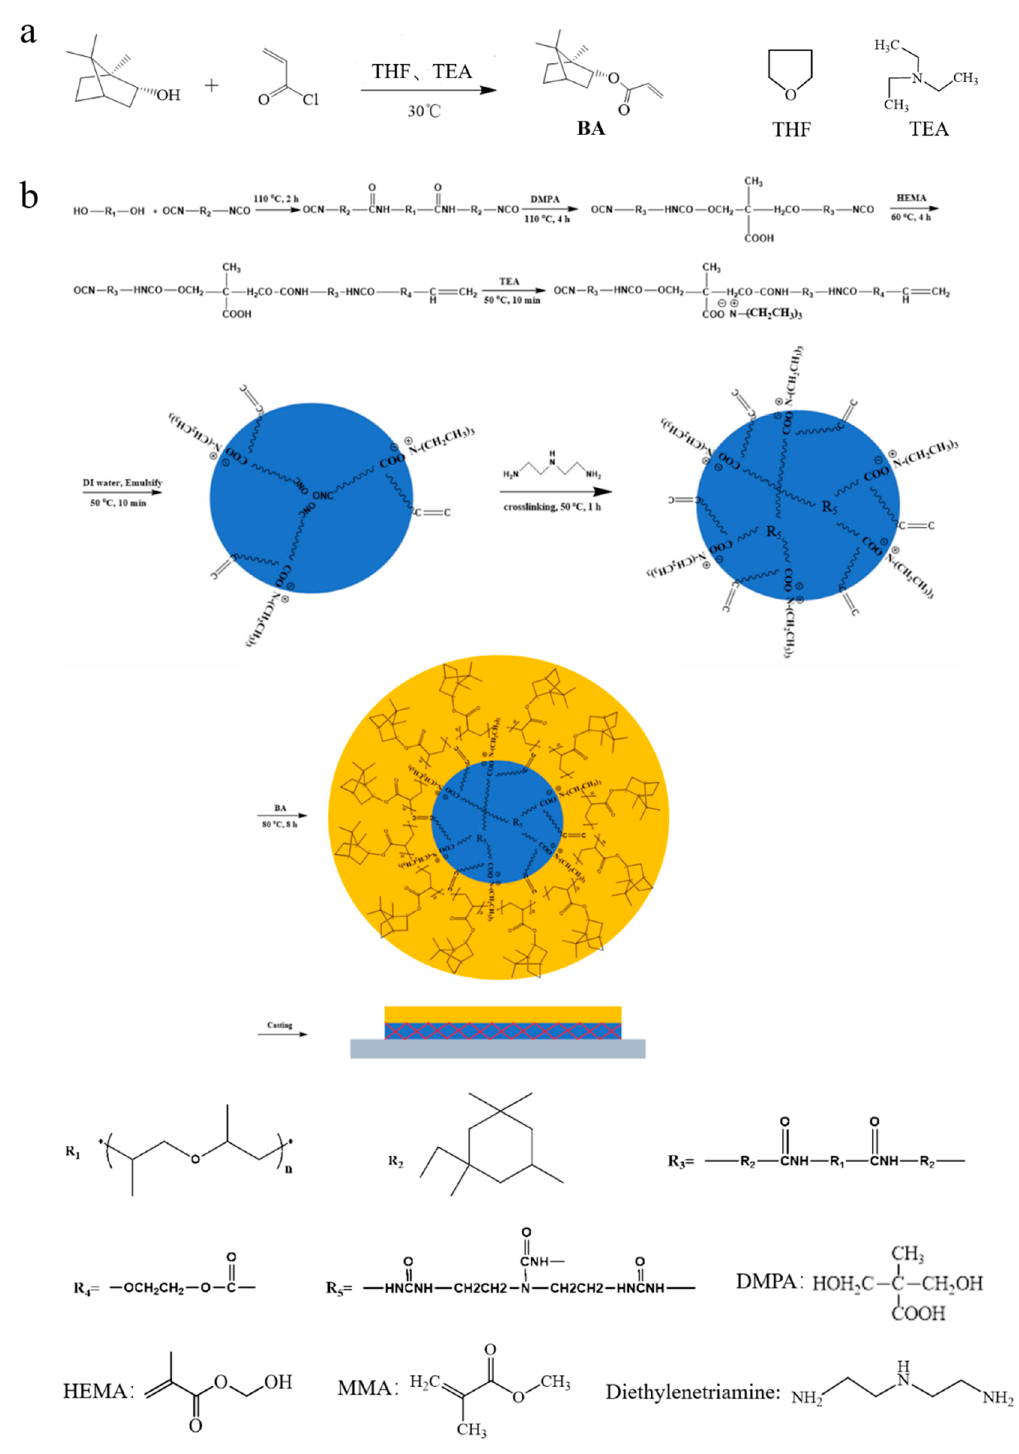
Figure 1. Schematic diagram of the fabrication process for ( a ) BA monomer and ( b ) Endo-L-Borneol based PUA film.